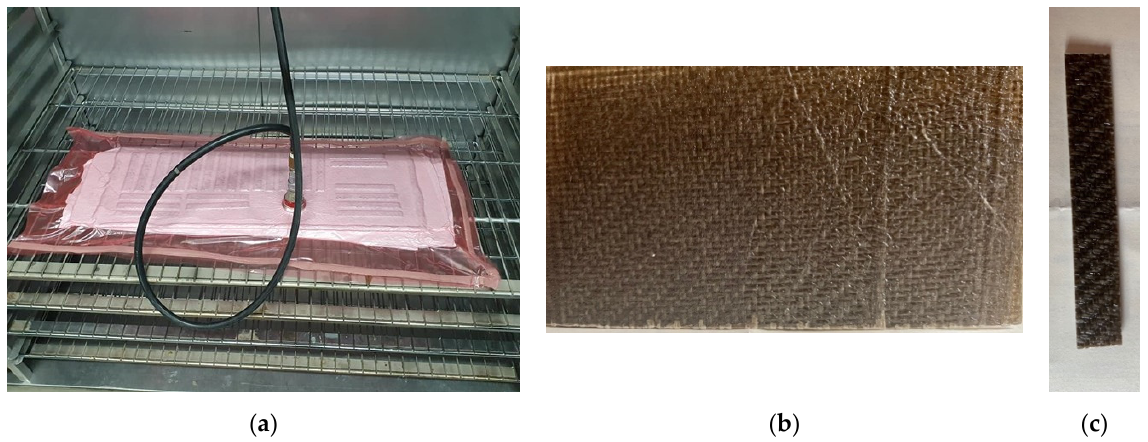
Figure 4. ( a ) Preparation of vacuum bagging; ( b ) Surface texture of the specimen; ( c ) Specimens after curing.